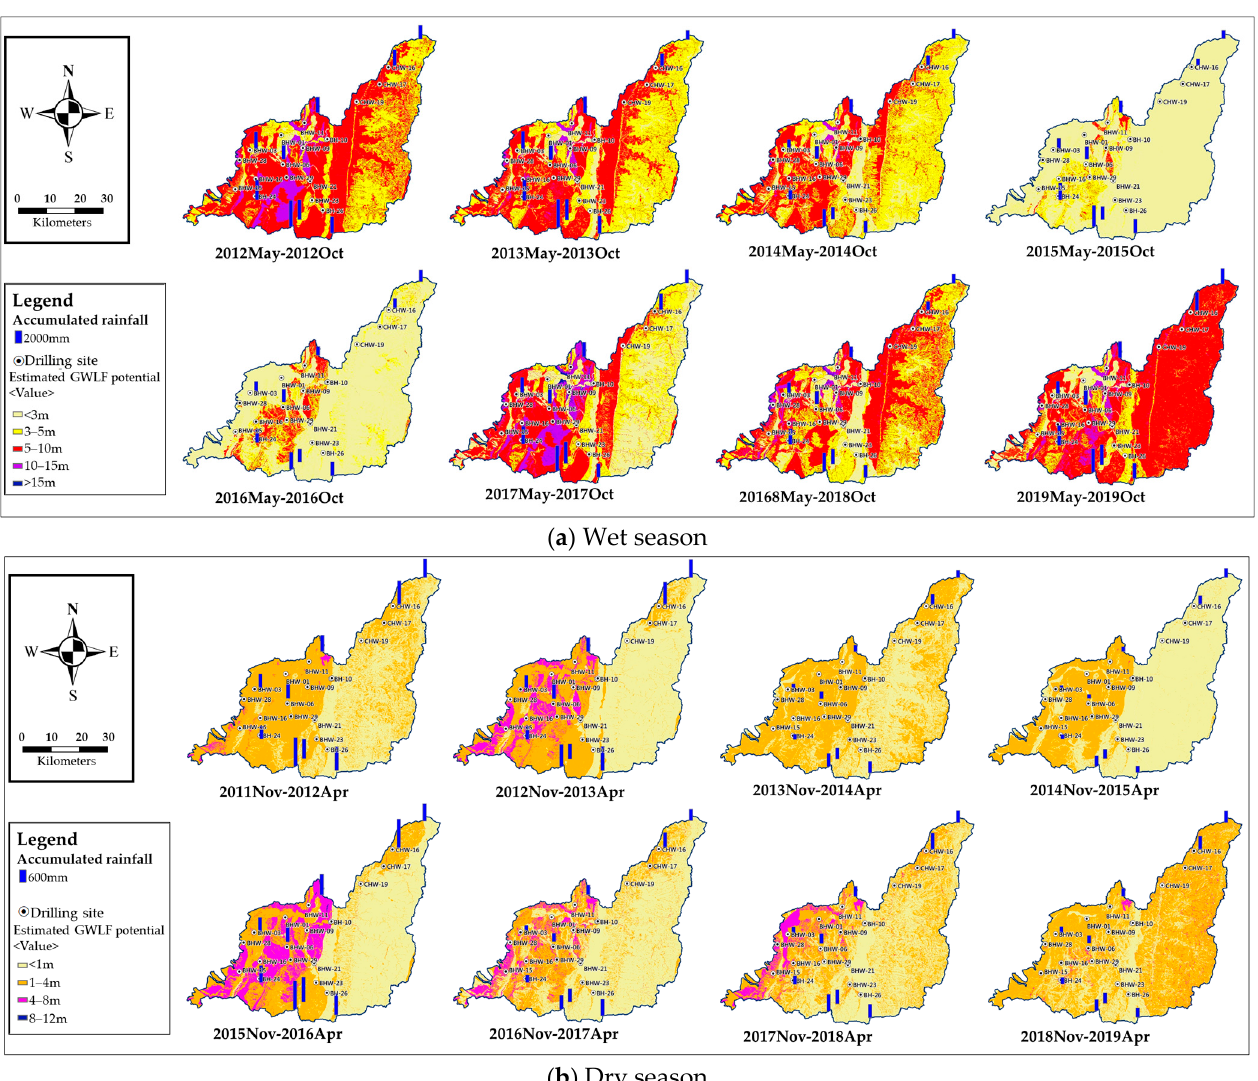
Figure 16. Spatial distribution of accumulated rainfall and estimated GWLF potential during 2011– 2019 in the wet/dry season. ( a ) Wet season, ( b ) dry season.